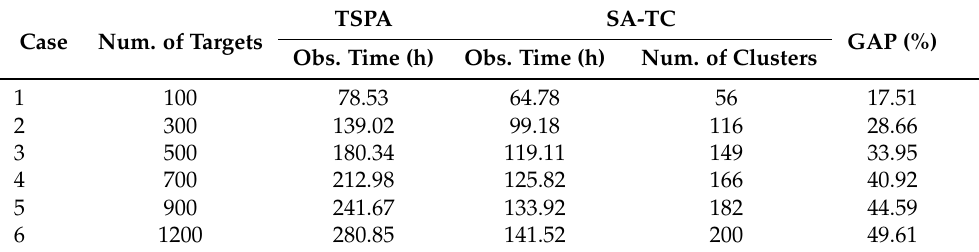
Table 2. Comparison results of airship observation scheduling approaches in 6